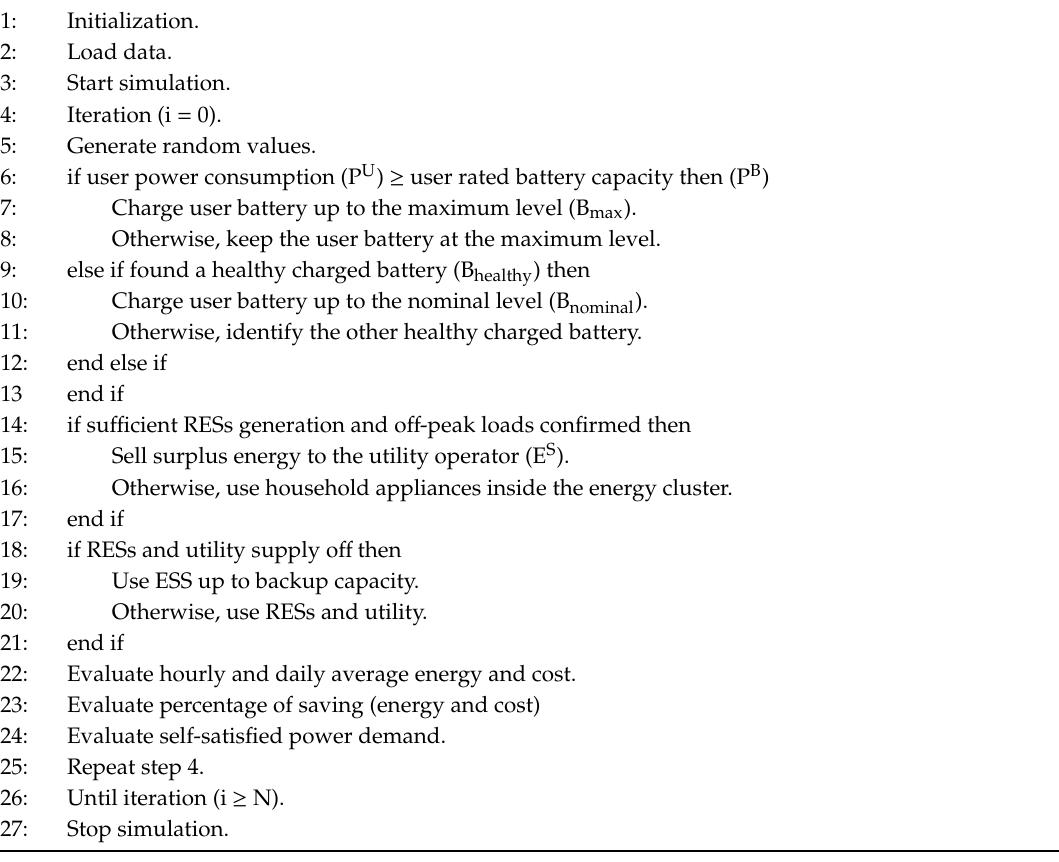
Algorithm 1 Energy Allocation Algorithm